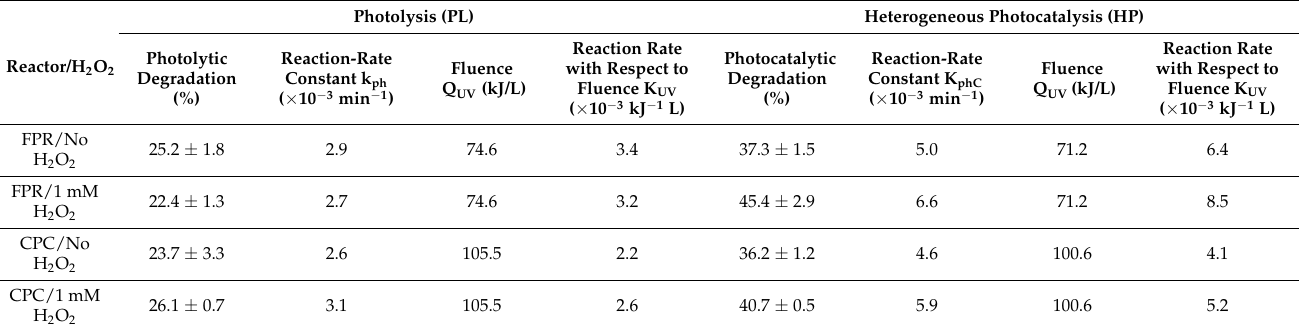
Table 1. Calculated photolytic and photocatalytic responses to UV reaction-rate constants. Photolysis (PL) Heterogeneous Photocatalysis Reactor/H 2 O 2